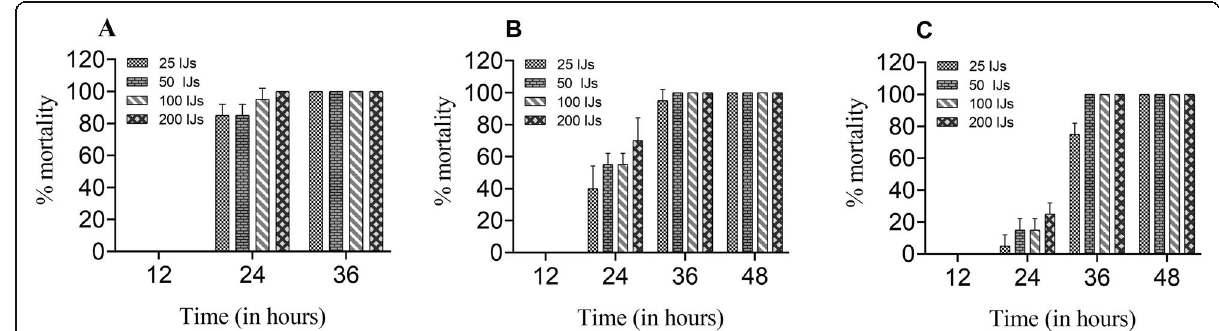
Fig. 4 a Percentage mortality in larvae of Galleria mellonella infected with different doses of Steinernema abbasi isolate CS38. b Percentage mortality in larvae of Helicoverpa armigera infected with different doses of Steinernema abbasi isolate CS38. c Percentage mortality in larvae of Spodoptera litura infected with different doses of Steinernema abbasi isolate